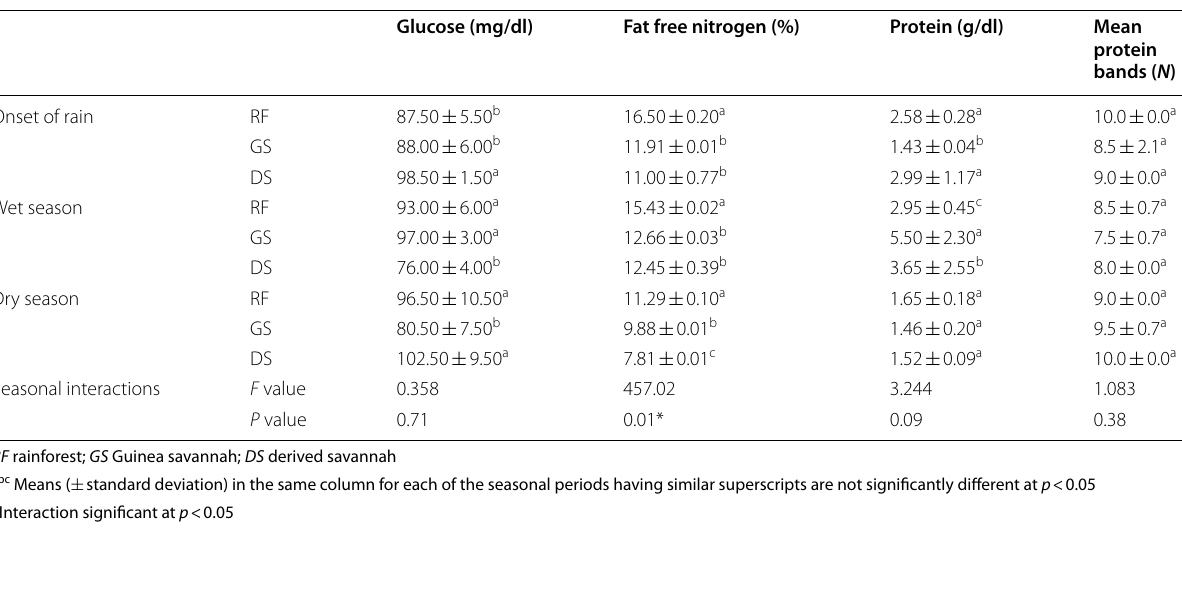
Table 5 Total body glucose, fat free nitrogen and protein composition of the honeybees from three ecological zones of Nigeria